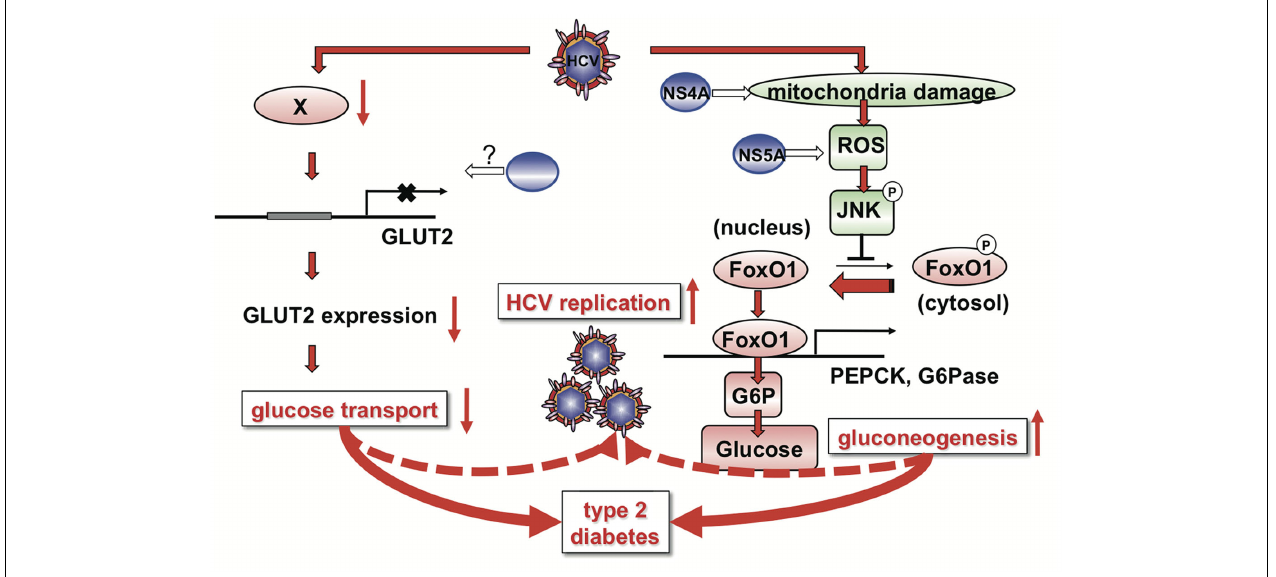
NS5A protein is involved in ROS production. HCV-induced ROS production causes JNK activation, resulting in the decreased phosphorylation and nuclear accumulation of FoxO1. Nuclear accumulation of FoxO1 up-regulates gene expression of PEPCK and G6Pase, leading eventually to increased glucose production by gluconeogenesis. High glucose levels in the hepatocytes may confer an advantage in efficient replication of